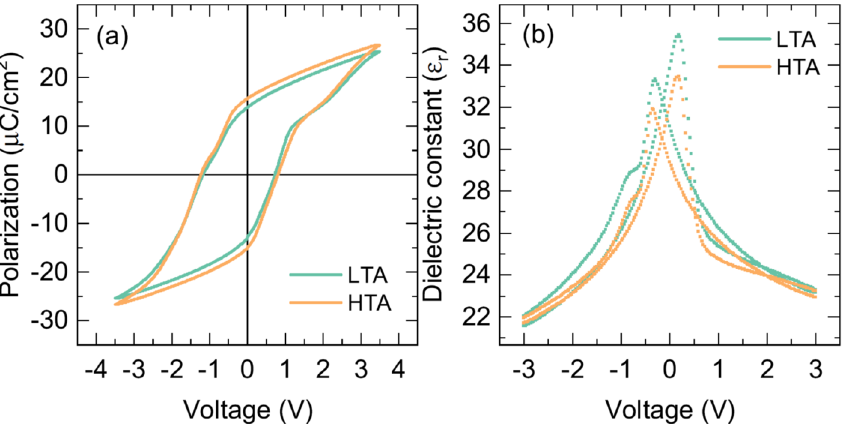
Figure 3. Macroscopic electrical properties of the HfO 2 films. ( a ) Polarization–voltage hysteresis of the LTA (green line) and HTA (orange line) films. ( b ) Capacitance–voltage measurement of the LTA (green squares) and HTA (orange squares) films.